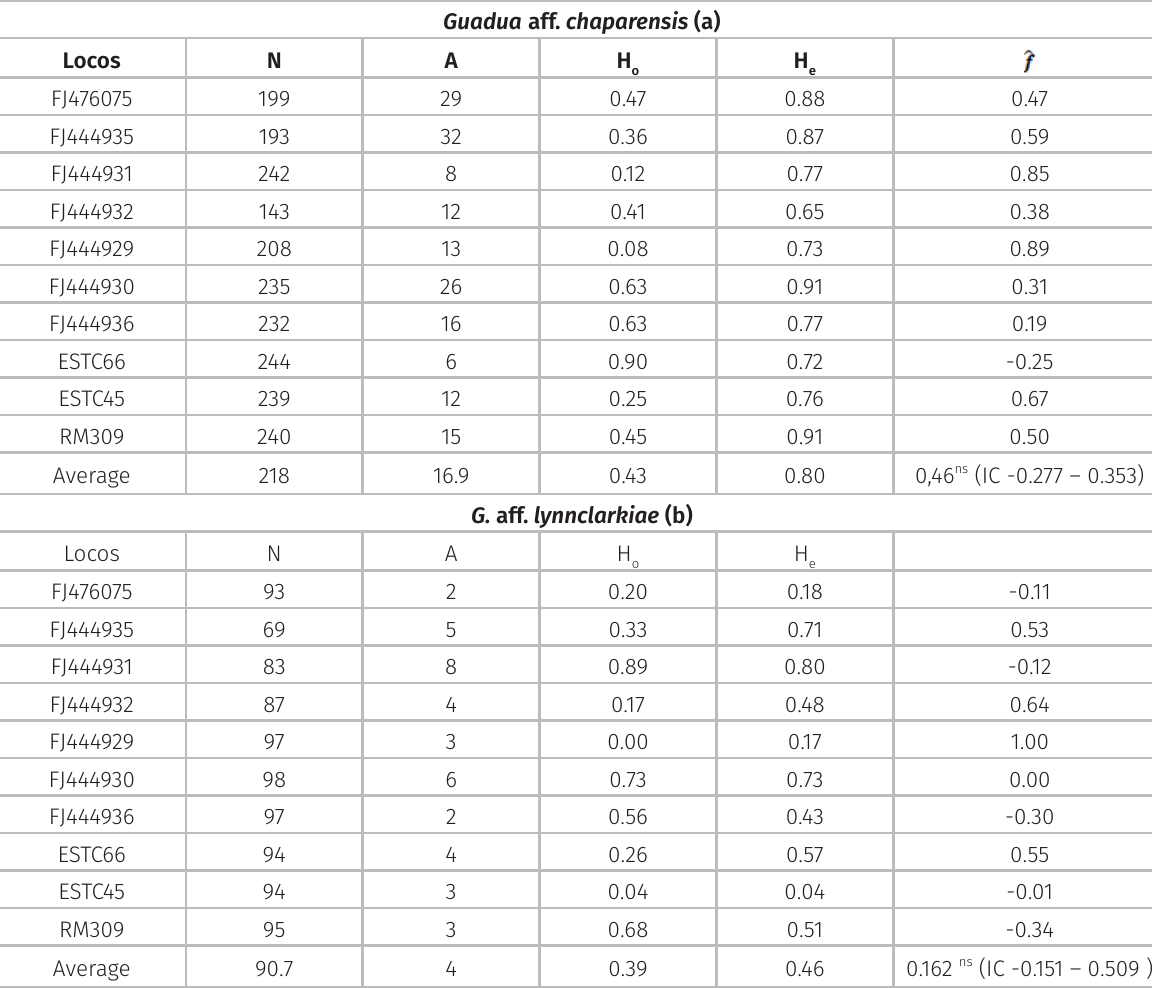
Table IV. Characterization of the SSR loci for the populations of Guadua aff. chaparensis in the municipality of Sena Madureira, AC ( a ) and G. aff. lynnclarkiae in the municipality of Porto Acre, AC ( b